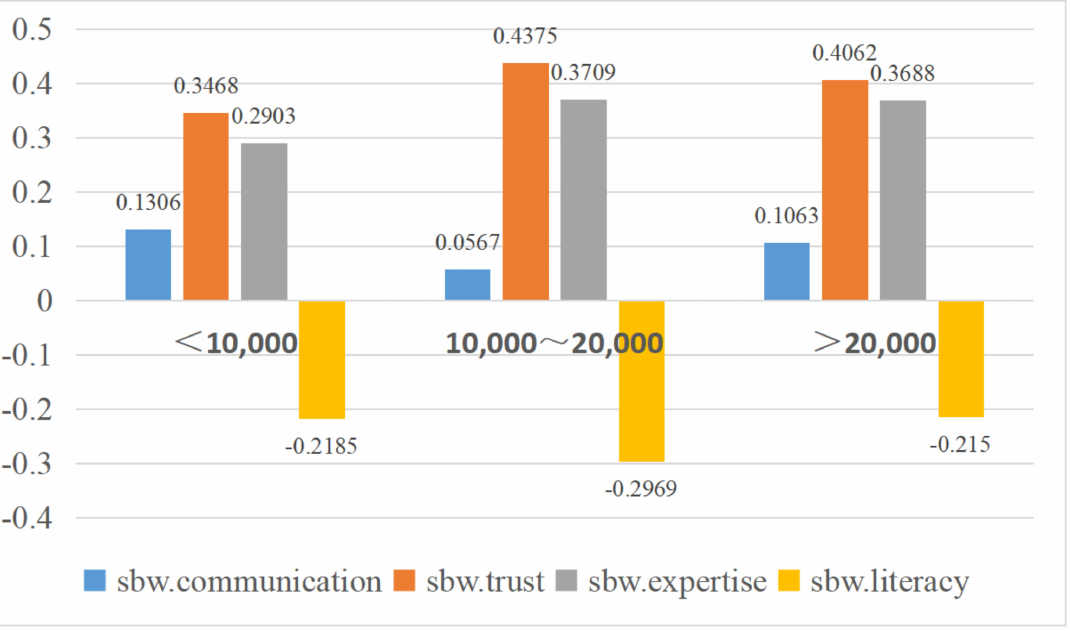
Figure A3. The best-worst scores for respondents with different monthly family incomes (CNY) on four statistically significant factors (SBW, standardized best-worst